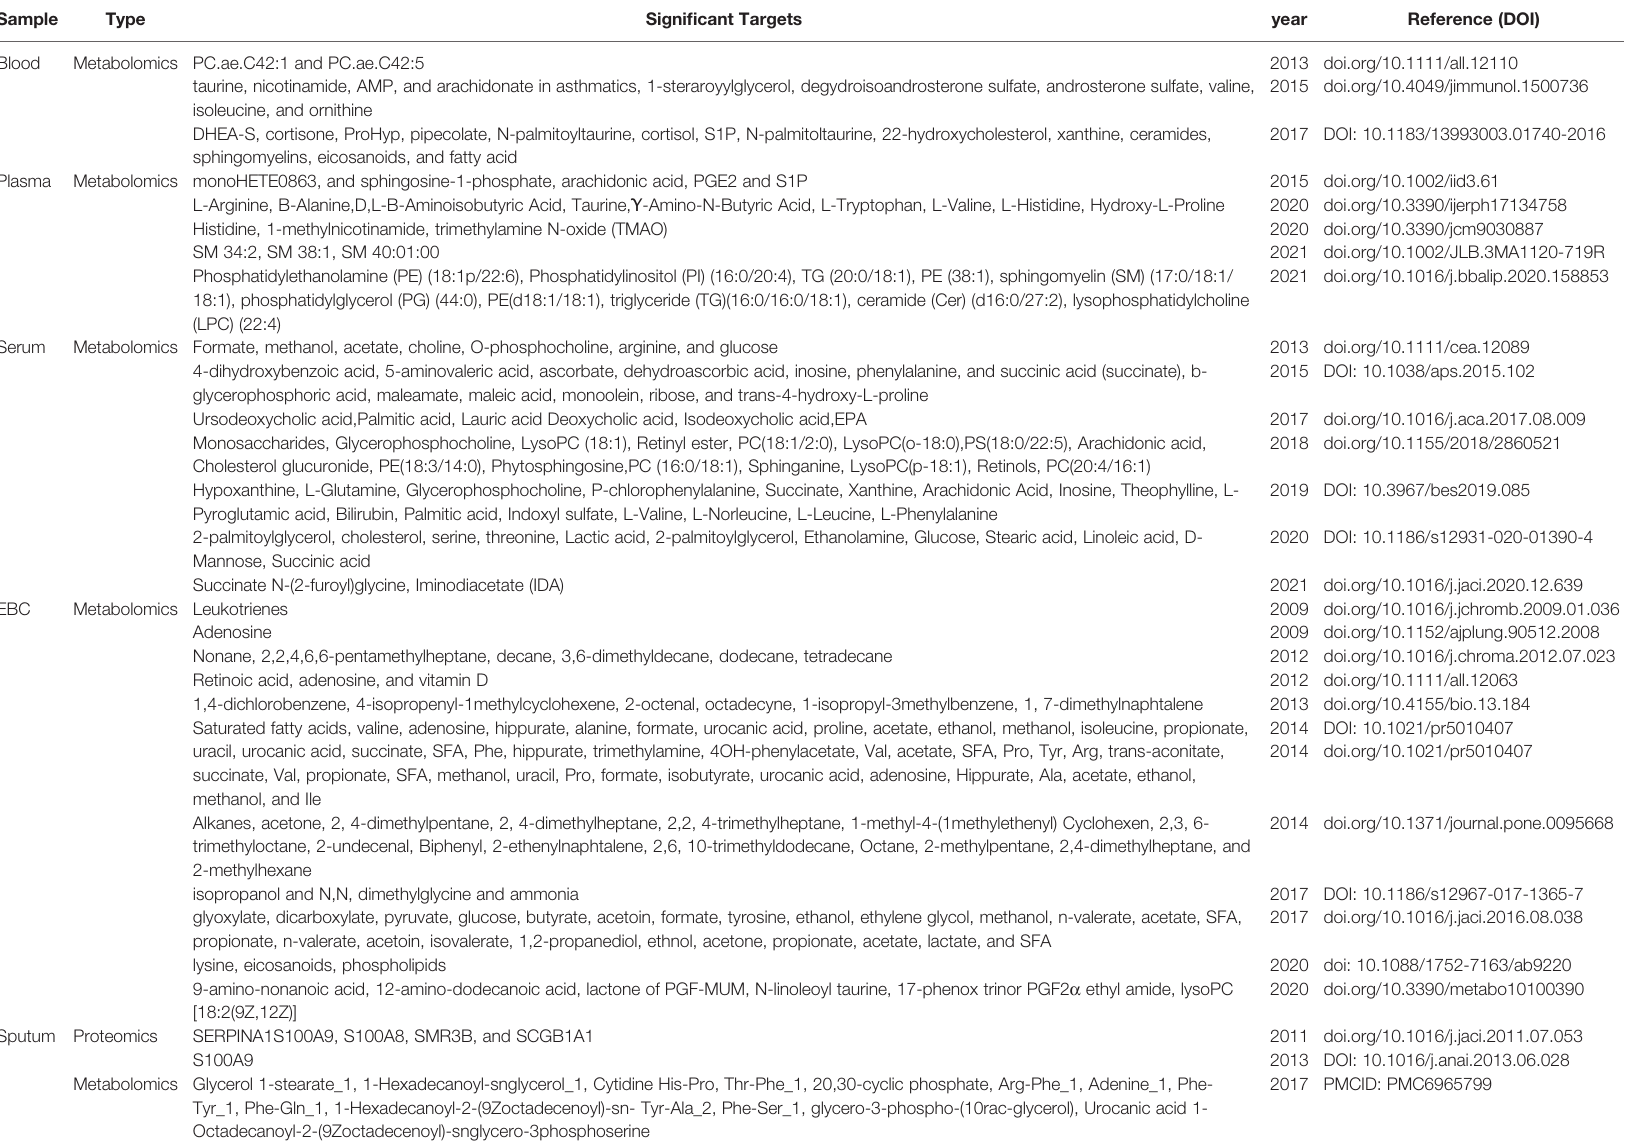
TABLE 2 | Signi fi cant Targets Resulting from Metabolomic and Proteomic Studies of Samples Derived from Asthmatic Patients.